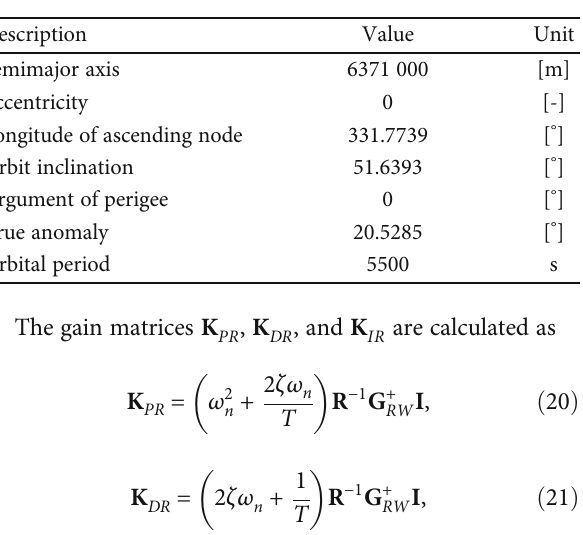
Table 2: Initial satellite orbital